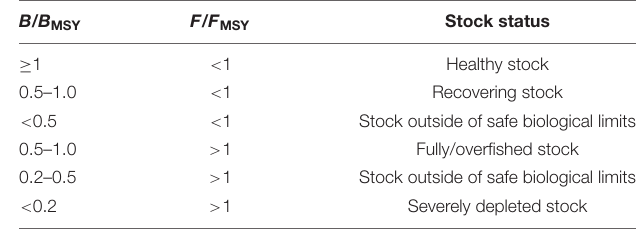
TABLE 4 | Definition of fish stock status, based on B / B MSY in the final year of a time series*.